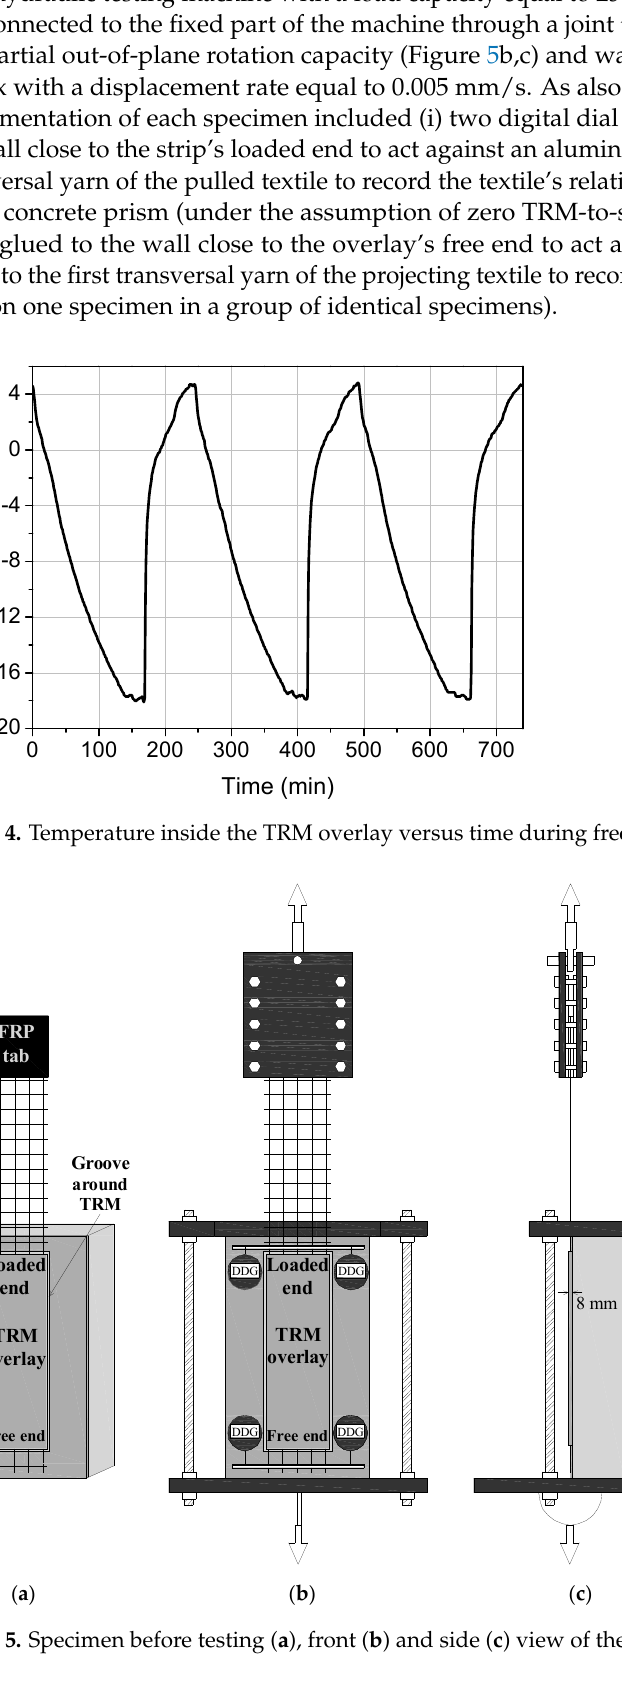
Figure 5. Specimen before testing ( a ), front ( b ) and side ( c ) view of the set-up.